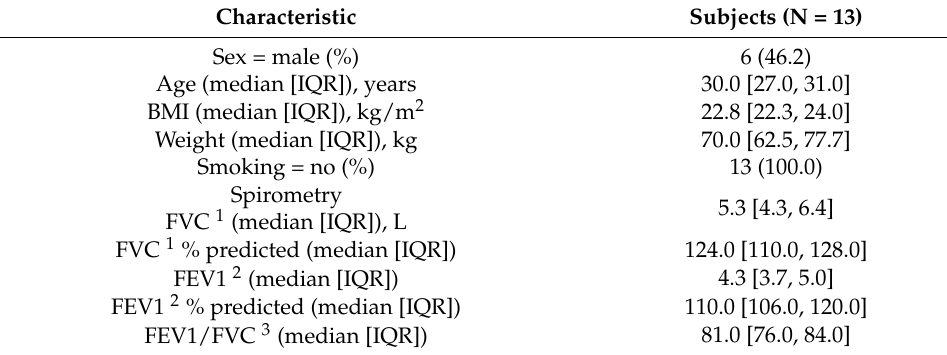
Table 1. Participant